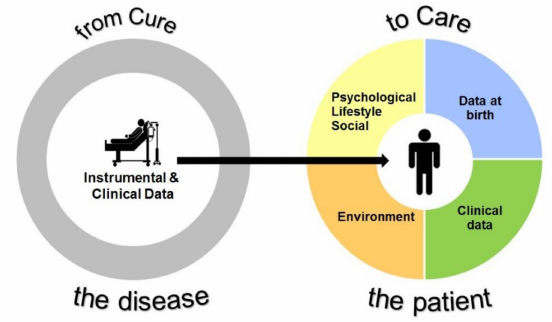
Figure 1. The PENSAMI